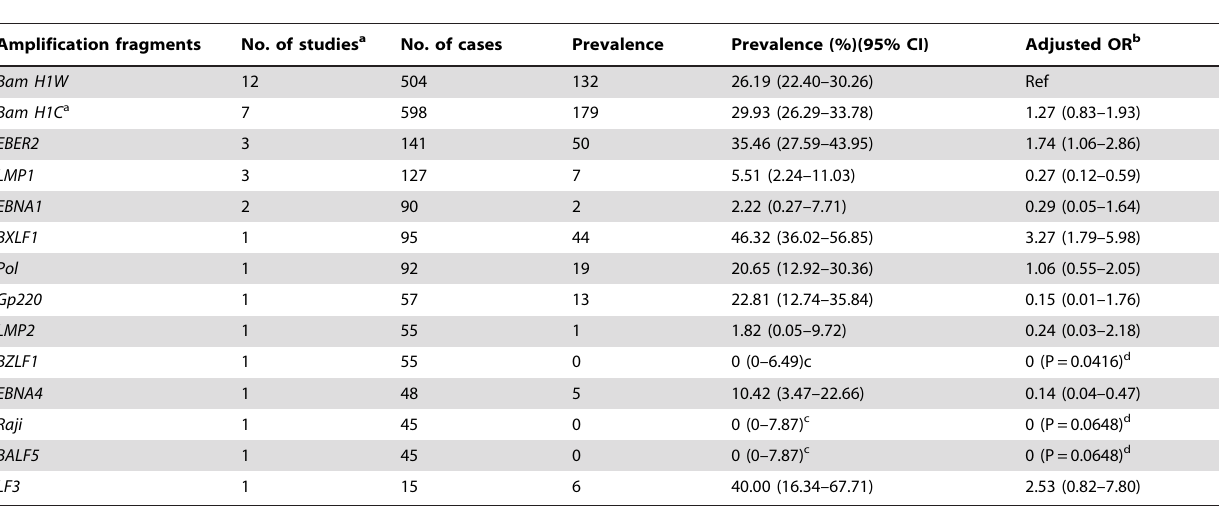
Table 2. Different primers used for detecting EBV prevalence in PCR analyses.